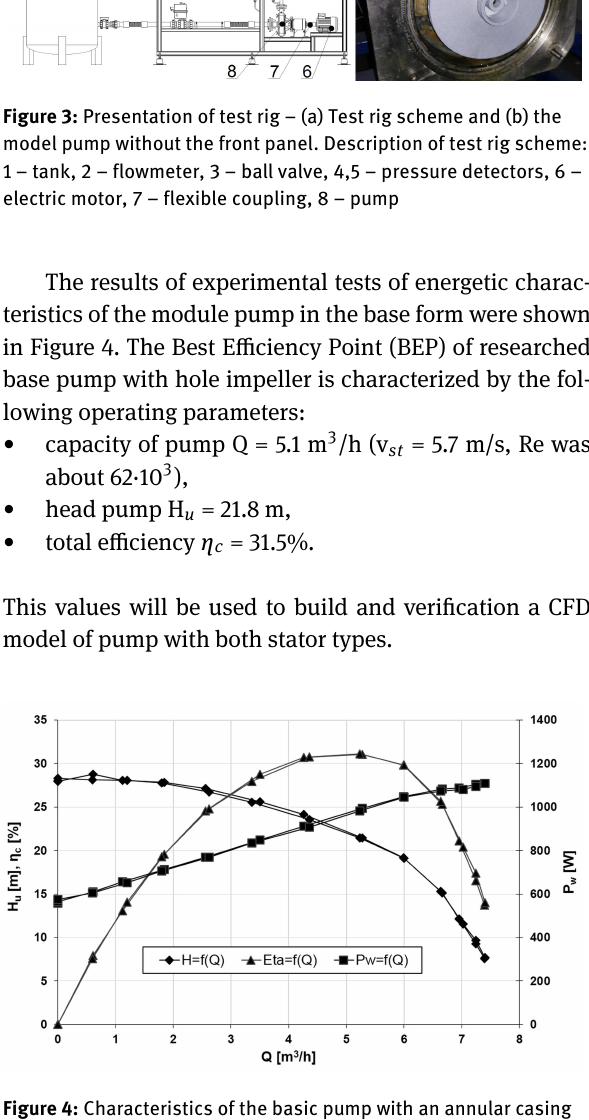
Figure 4: Characteristics of the basic pump with an annular casing and a hole impeller